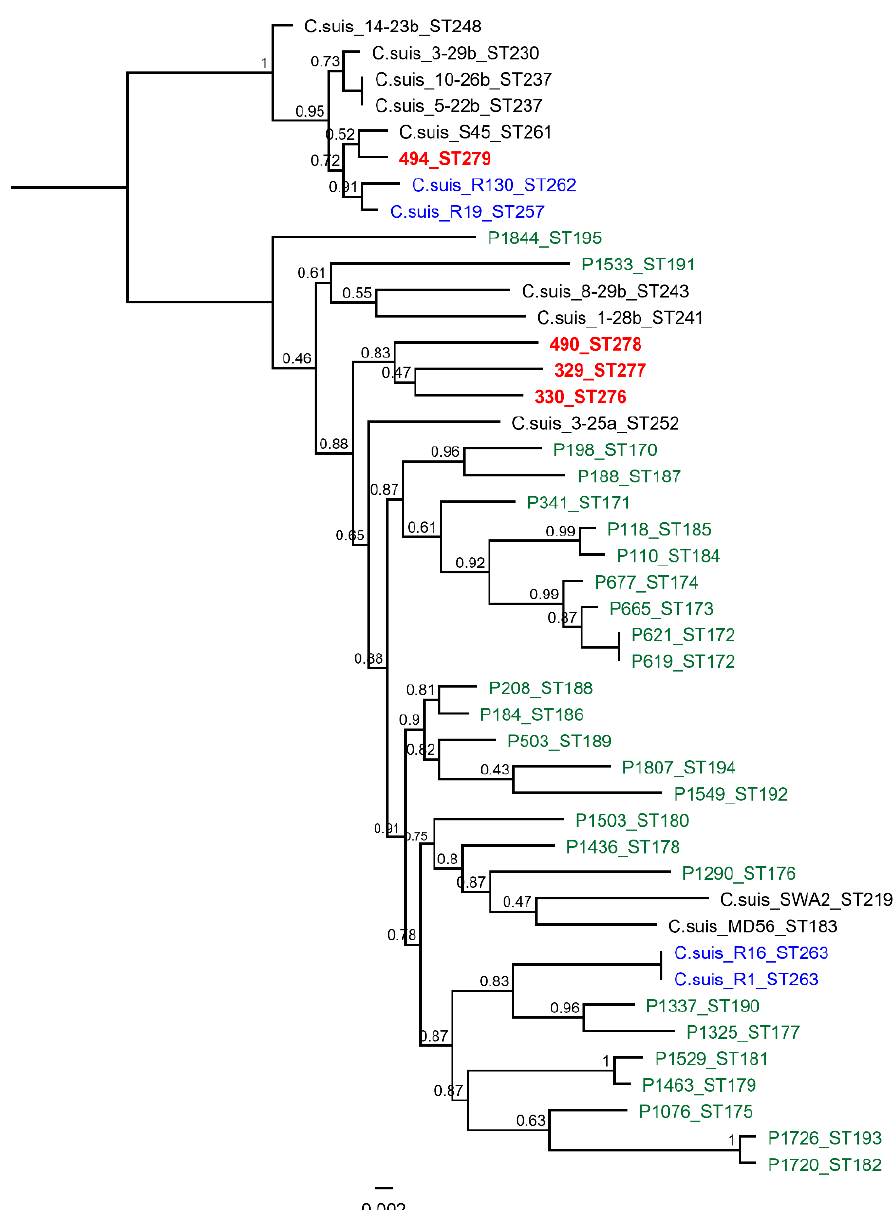
Figure 1. The mid-point rooted approximately-maximum-likelihood phylogenetic tree constructed using an alignment of concatenated multilocus sequence typing (MLST) sequences from the four isolates from this study, and an additional ten European, four US, and twenty-six Chinese C. suis isolates. The support values are displayed on the nodes. The isolates from this study are denoted in bold and red letters, other European strains in black, US strains in blue, and Chinese strains in green. ST for each is denoted at the end of the strain name. The figure was created in Geneious Prime v.2019.1, Biomatters (www.geneious.com).